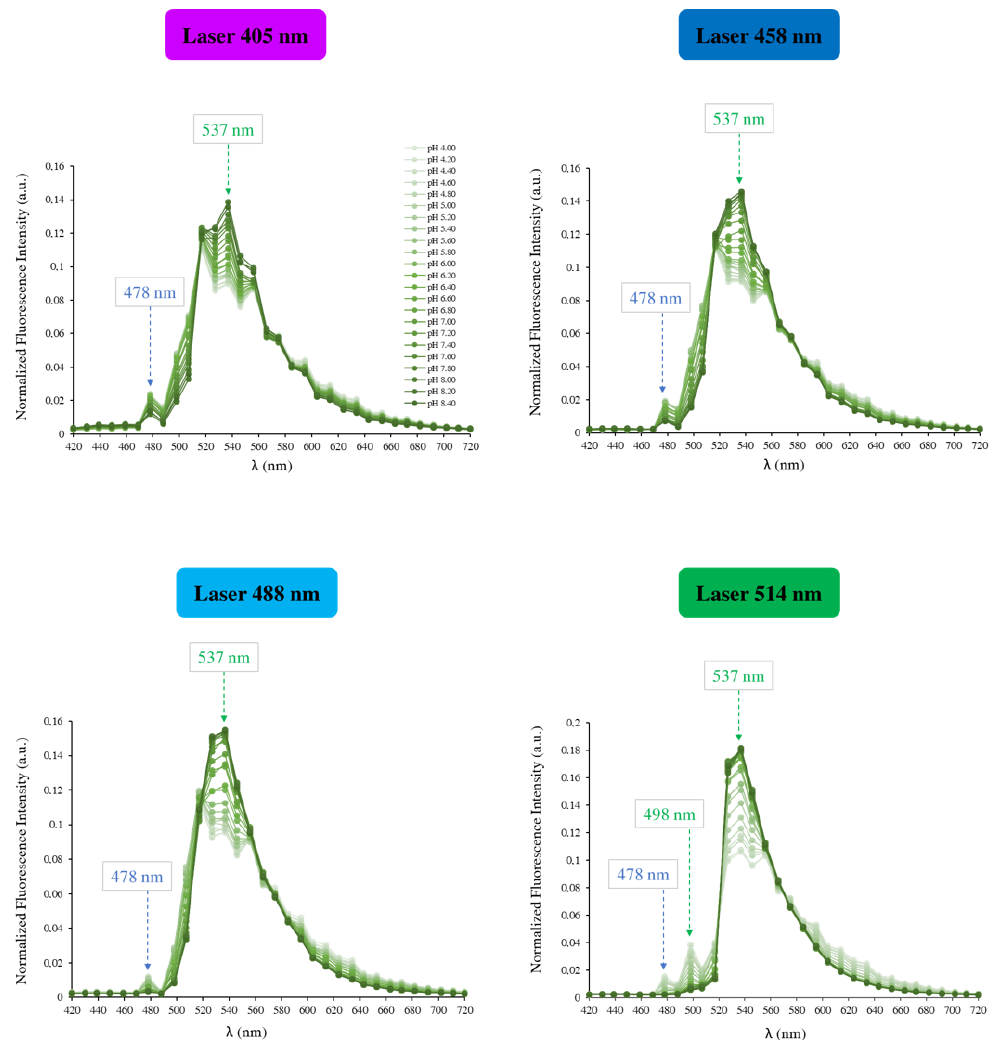
Figure 6. BCECF (5 µ M) emission spectra at 405 nm, 458 nm, 488 nm and 514 nm excitation wave- lengths, in DMEM free-serum medium at various pH values from 4.0 to 8.4 with 0.2 pH increments controlled with a pH meter. The pH-sensitive emission wavelengths assessed for the ratiometric measurements are represented by